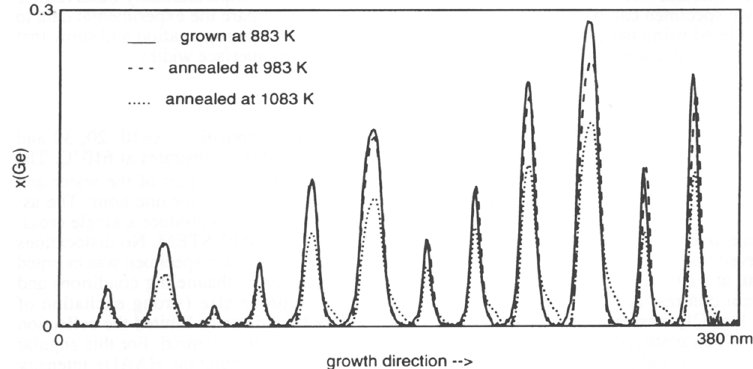
Figure 7. Example of interdiffusion by annealing of SiGe multilayers at 100 K above growth temperature (dashed) vs interdiffusion and some surface segregation at 200 K above growth temperature (dotted). Reproduced from [34], with permission from Scitec, 4 June 2019.